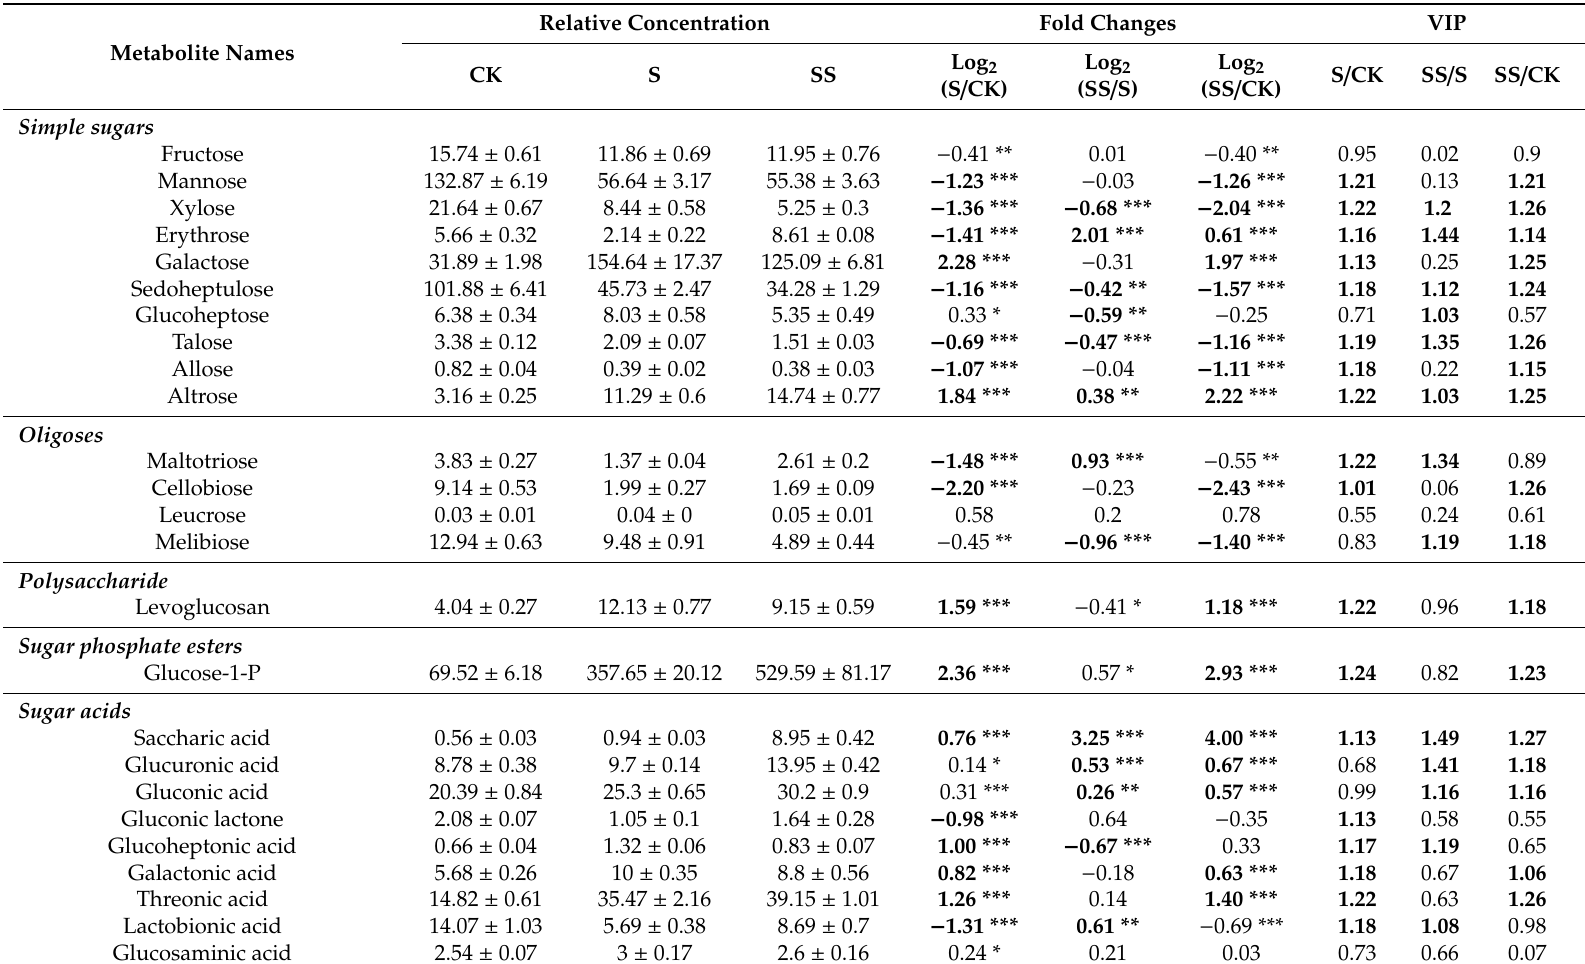
Table 1. Root other metabolites responsive to salt stress and Spd (Metabolites not shown in Figure